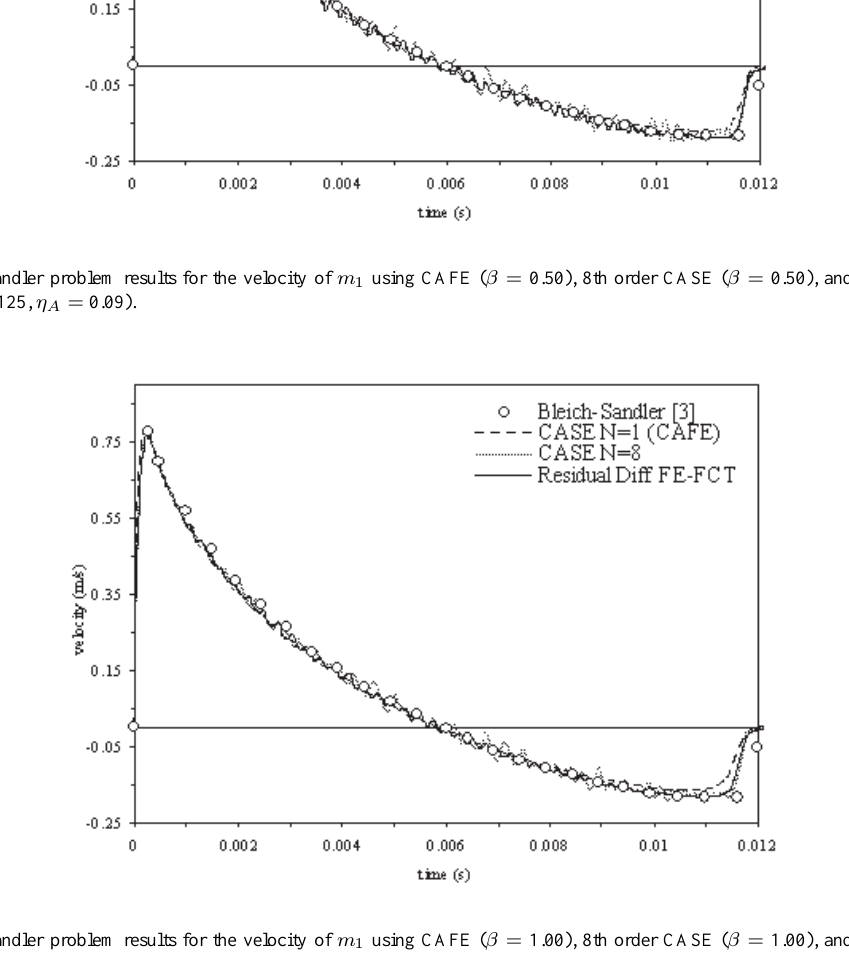
Fig. 16. Bleich-Sandler problem results for the velocity of m 1 using CAFE ( β = 1.00), 8th order CASE ( β = 1.00), and residual diffusion FE-FCT ( η D = 0.125, η A =